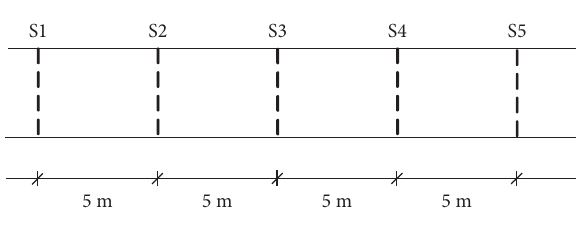
Figure 3: Section